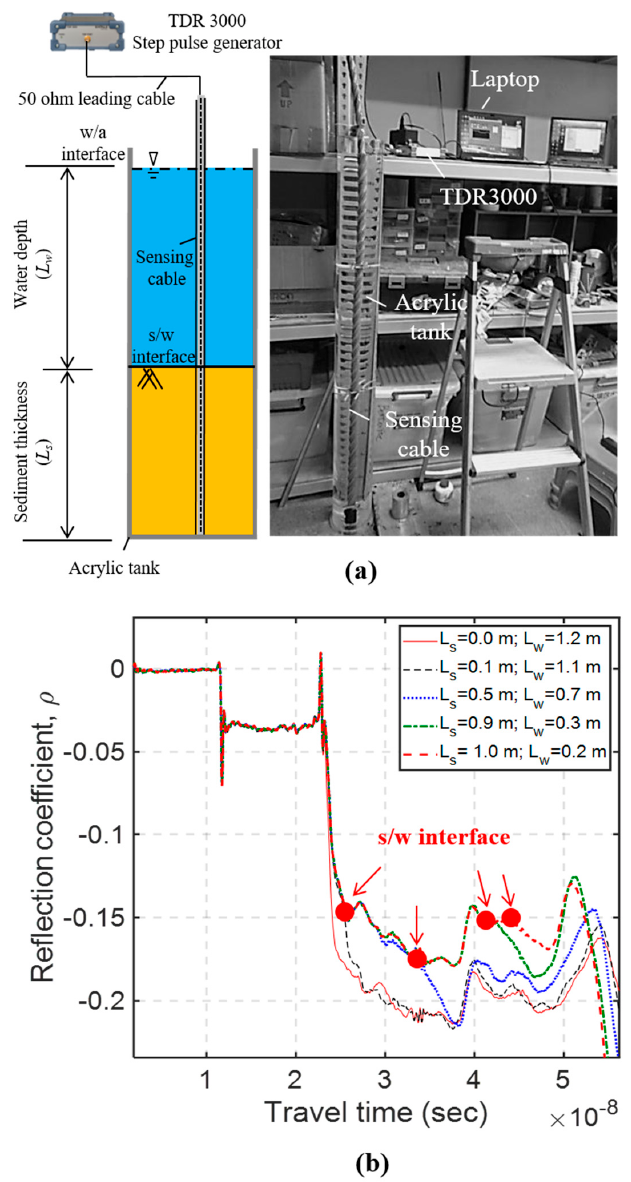
Figure 3. ( a ) Laboratory experiment setup; and ( b ) the recorded raw waveforms of the Type III TDR sensing cable.